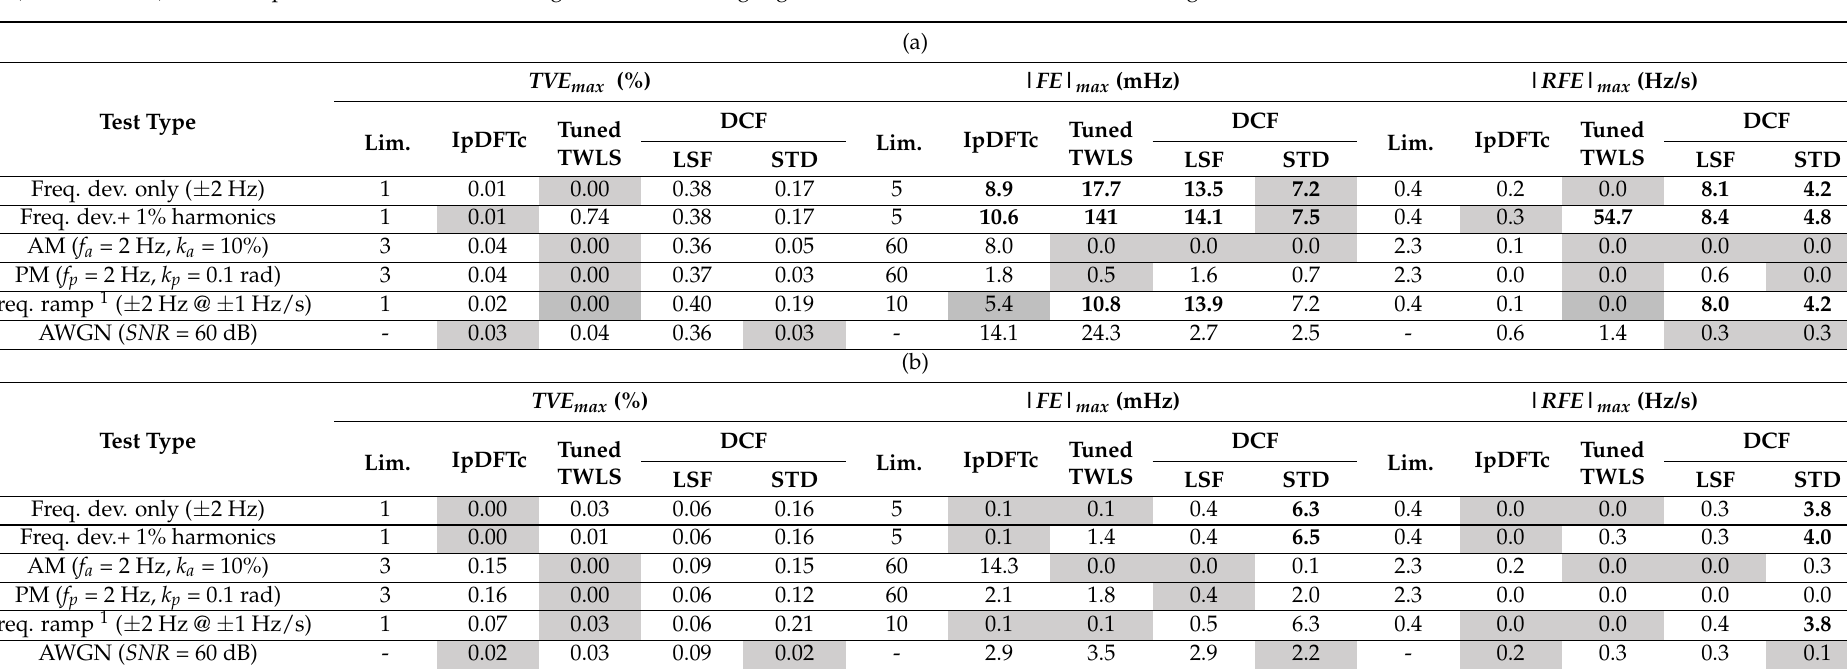
Table 4. Maximum TVE, |FE|, and |RFE| values obtained with the estimation algorithms for PMUs described in Section 2 over 2-cycle (a) or 4-cycle (b) observation intervals. All the testing conditions, except the one with the additive wideband noise, are specified in the IEEE/IEC Standard 60255-118-1:2018 for P Class PMUs [10]. The limits mentioned in the Standard (when defined) are also reported. The values exceeding such limits are highlighted in bold, whereas the cells containing the best results obtained in each test are